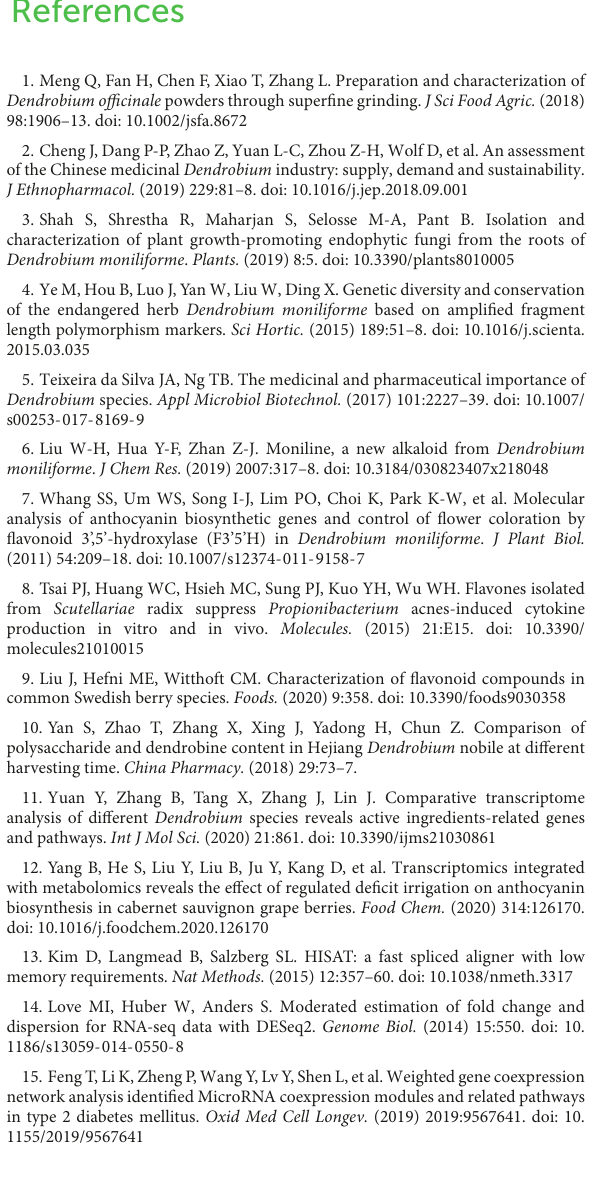
of the enriched pathway, the more significant it is. (A) 1Dm vs. 2Dm; (B) 1Dm vs. 3Dm; (C) 1Dm vs. 4Dm; (D) 2Dm vs. 3Dm; (E) 2Dm vs. 4Dm; (F) 3Dm vs. 4Dm. SUPPLEMENTARYFIGURE8 Top 20 KEGG pathways. (A) 1Dm vs. 2Dm; (B) 1Dm vs. 3Dm; (C) 1Dm vs. 4Dm; (D) 2Dm vs. 3Dm; (E) 2Dm vs. 4Dm; (F) 3Dm vs. 4Dm. SUPPLEMENTARYFIGURE9 The heatmap of the expression of hub genes in four modules. (A) yellow module; (B) brown module; (C) turquoise module; (D) black module. SUPPLEMENTARYTABLE1 Gene IDs and primers used in the quantitative real-time PCR (qRT-PCR) experiments. SUPPLEMENTARYTABLES2–7 The complete list of identified